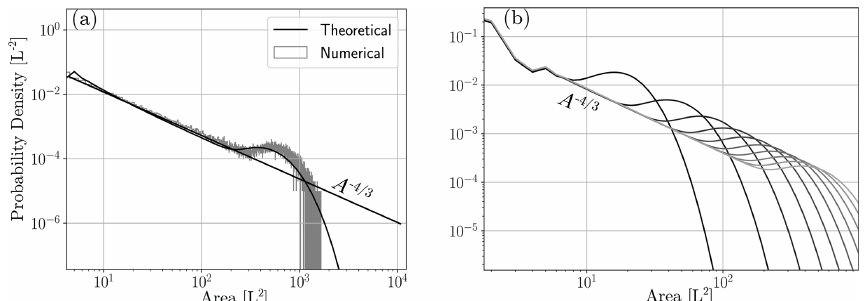
Figure 7. (a) Probability distribution of contributing area on a hillslope according to theory and a numerical exercise of 100000 simulations of w ( s ) on a hillslope with 100 levels. (b) Probability distribution of contributing area for hillslopes of increasing length.